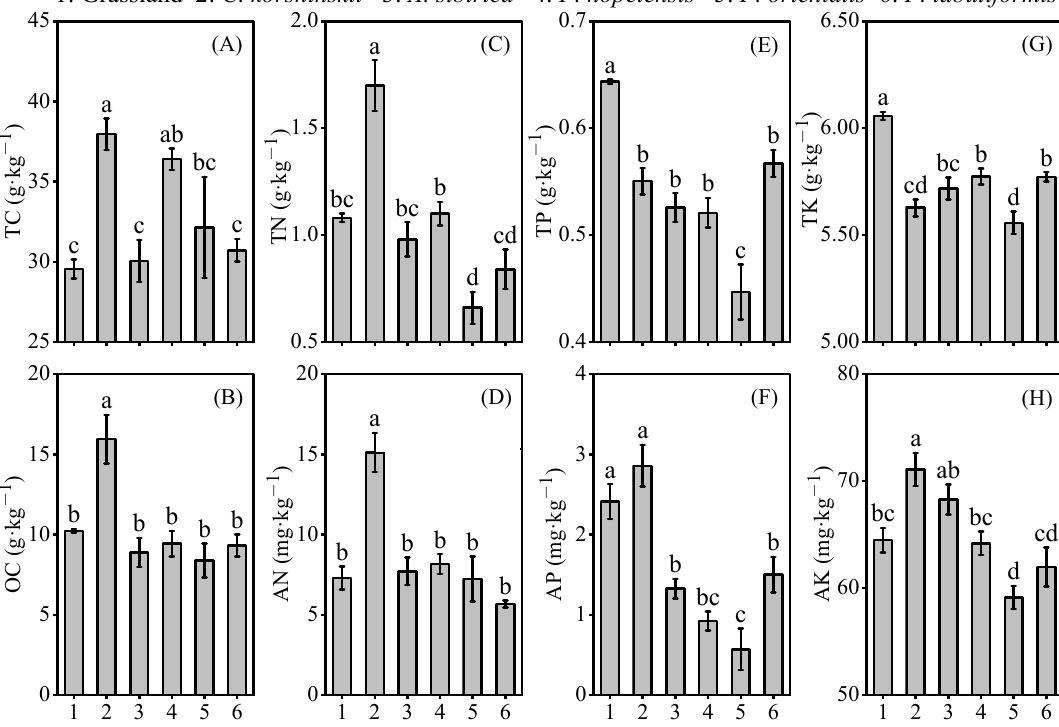
Figure 1. ( A – H ) indicate different small panels, which are 8 soil nutrient properties. The impact of different vegetation types Figure 1. The impact of different vegetation types on soil carbon, nitrogen, phosphorus, and potassium contents: TC, total on soil carbon, nitrogen, phosphorus, and potassium contents: TC, total carbon; OC, organic carbon; TN, total nitrogen; AN, carbon; OC, organic carbon; TN, total nitrogen; AN, available nitrogen; TP, total phosphorus; AP, available phosphorus; available nitrogen; TP, total phosphorus; AP, available phosphorus; TK, total potassium; AK, available potassium. Different TK, total potassium; AK, available potassium. Different lowercase letters indicate significant differences among the six vegetation types ( p < 0.05). lowercase letters (a–d) indicate significant differences among the six vegetation types ( p <